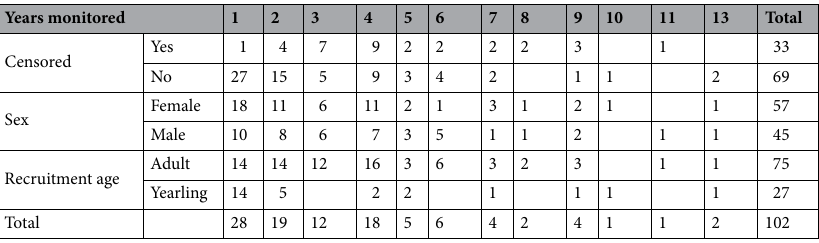
Table 2. Number of peregrines monitored for different consecutive years, split by those monitored over their full lifespan or not (censored), sex, and age at recruitment. Data in the first two rows correspond with those used in actuarial senescence analyses.